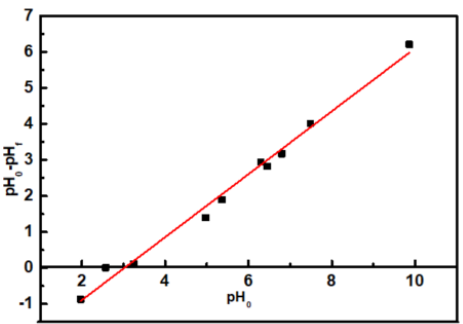
Figure 11. The point of zero charge of PP-g-(AA-MAH) fiber in the aqueous solution.